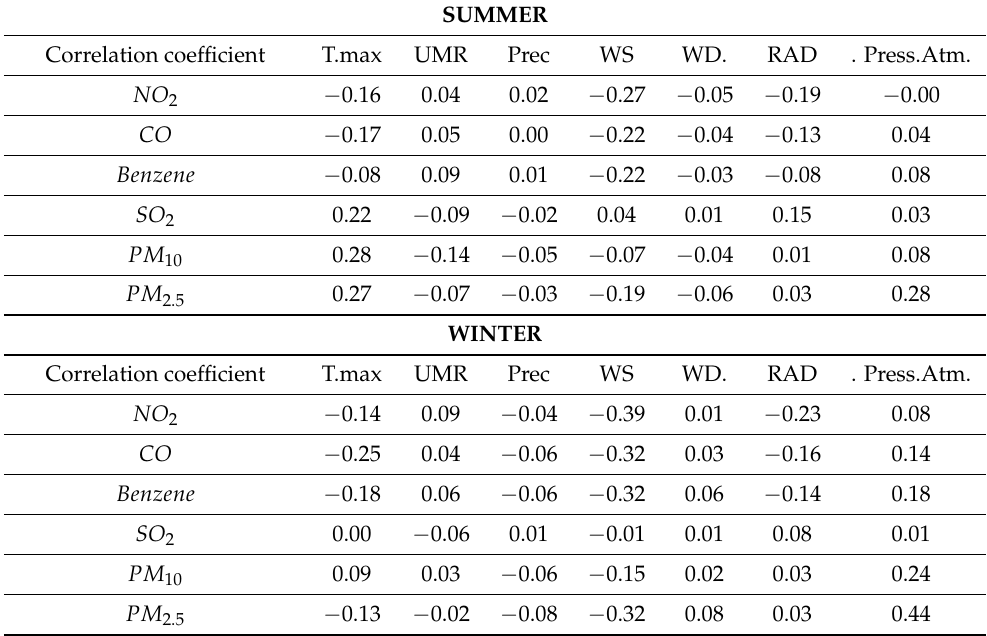
Table 3. Correlation coefficients between the 6 air quality variables and the 7 meteorological variables for both summer (above) and winter (below) period. SUMMER Correlation coefficient T.max UMR Prec WS WD. RAD .